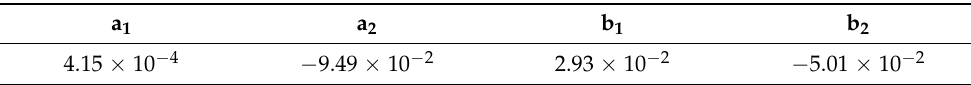
Table 2. Fitting parameters of